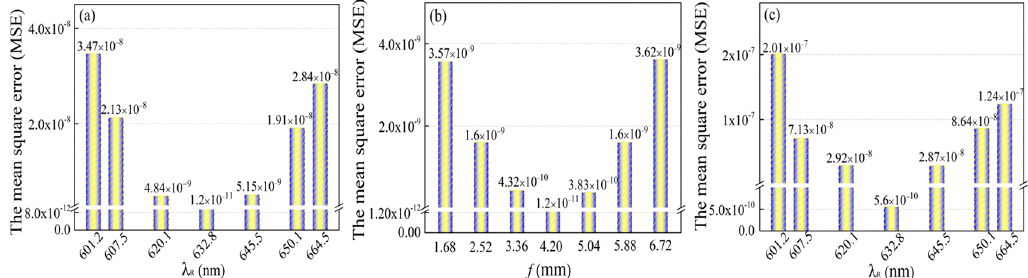
Figure 9. The MSE of data decrypted using the different ( a ) reference waves from 601.2 nm to 664.5 nm and ( b ) focal lengths from 1.68 mm to 6.72 mm. ( c ) The MSE of data decrypted for the other method (remove the Fourier lens from the VOHE system and leaving only holographic encryption) using different reference waves from 601.2 nm to 664.5 nm.